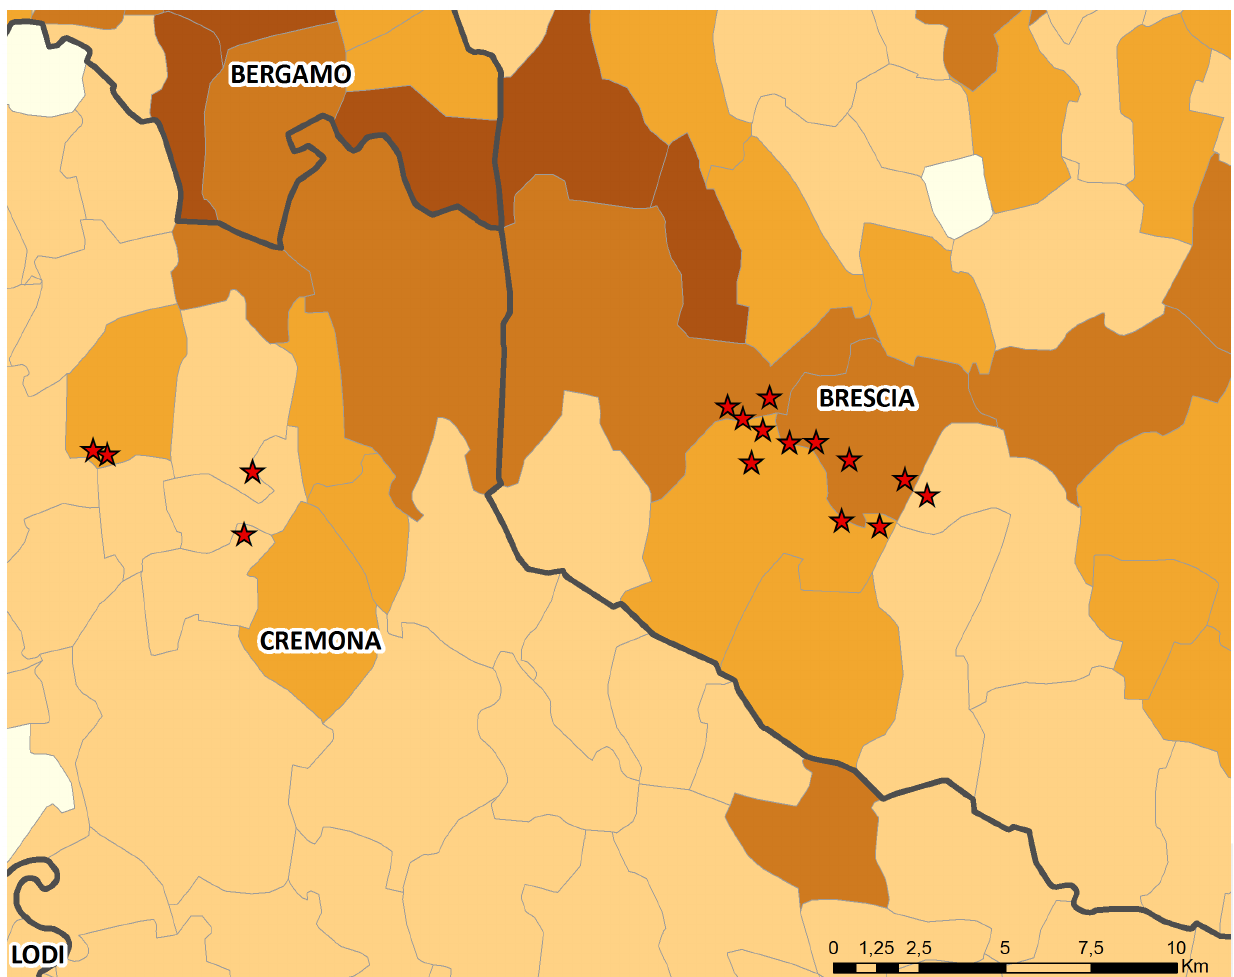
Figure 3. Outbreak locations in period 2. Detail of the areas affected by the epidemic in period 2. Across the affected area in Brescia that was pre-emptively depopulated, the local farm density is close to 1 farm per km 2 (for details see Figure 5 of [2]).